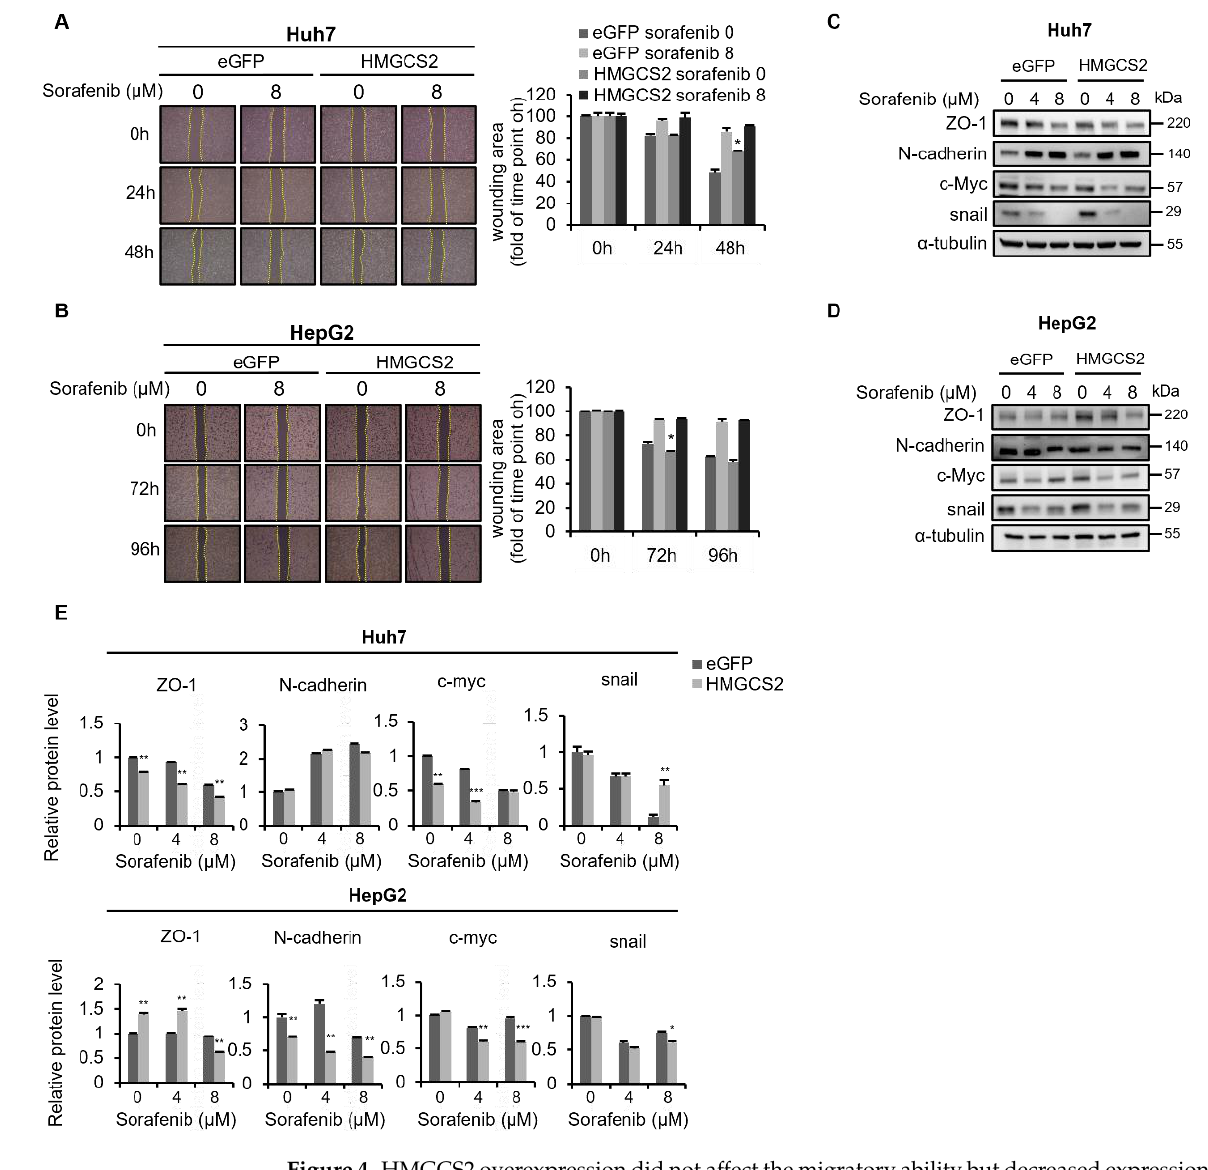
Figure 4. HMGCS2 overexpression did not affect the migratory ability but decreased expressions of N-cadherin and c-Myc in both sorafenib-treated Huh7 and HepG2 cells. ( A , B ) HMGCS2-overexpressing cells (4.3 × 10 5 cells/well of Huh7 cells and 10 6 cells/well of HepG2 cells) were seeded in ibidi culture inserts and treated with 0 and 8 µ M sorafenib. Images were collected at the indicated time points and wound-healing areas were measured with ImageJ software, as shown in the column charts. ( C , D ) Cells were treated with sorafenib at concentrations of 0, 4, and 8 µ M for 48 h. Protein expression levels of zonula occludens (ZO)-1, N-cadherin, c-Myc, and Snail were evaluated by Western blotting. α -Tubulin was used as a loading control. The representative data are obtained from three independent experiments. ( E ) Western blot images from Figure 4C,D were quantified by ImageJ software. * p < 0.05; ** p < 0.01; *** p < 0.001 vs. the enhanced green fluorescent protein (eGFP) control. Data are shown as the mean ±